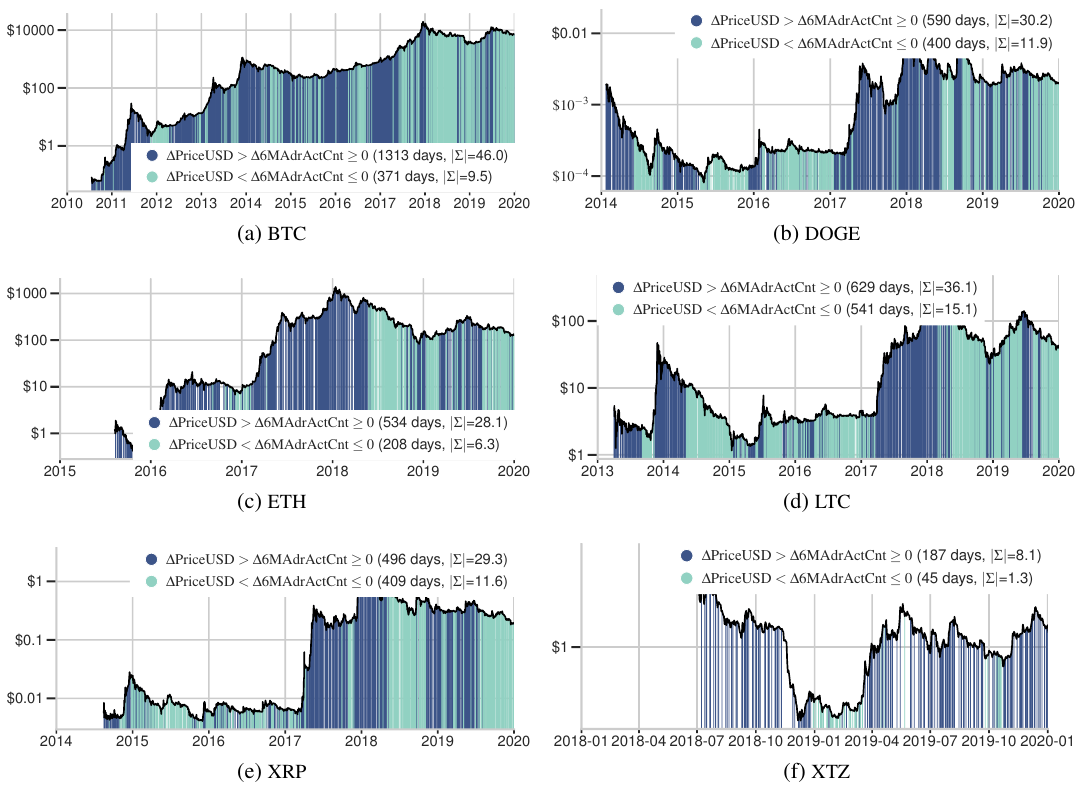
Fig. 3. Network effect observations and distribution (blue: positive NFX, green: reverse NFX, white: no NFX); userbase measured by trailing 6 month addresses, value measured by USD token